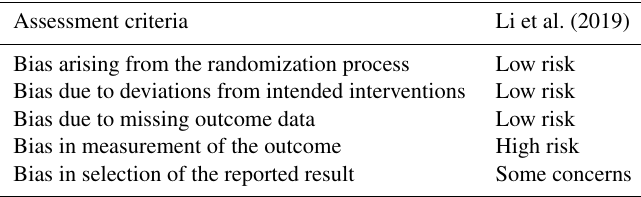
Table 3. Risk of Bias 2 (RoB 2) for randomized controlled trials.